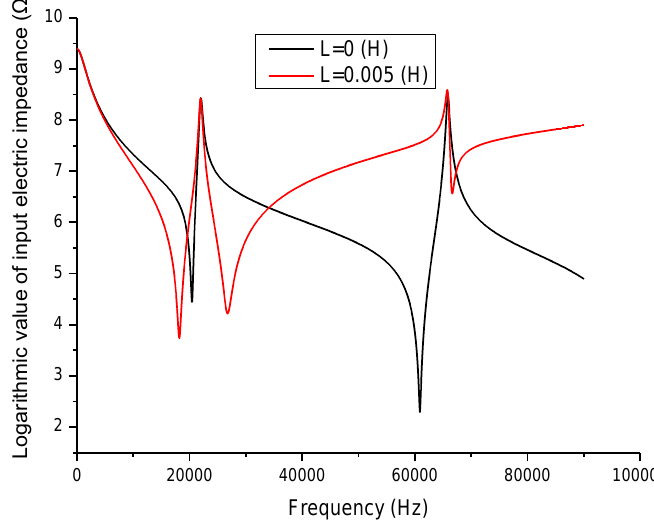
Figure 5. Frequency response of the input electric impedance.